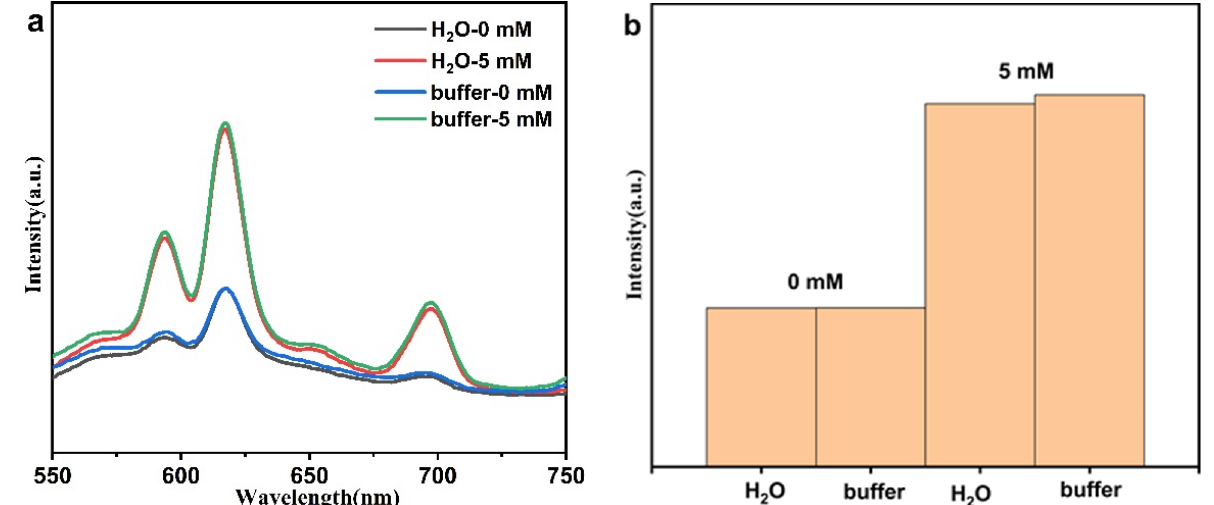
Figure 5. ( a ) The emission spectrum of PAA-Ca(Eu) nanoclusters in aqueous solution and buffer solution after reacting with different concentrations of PO 43 − , ( b ) luminescence intensity at 617 nm.